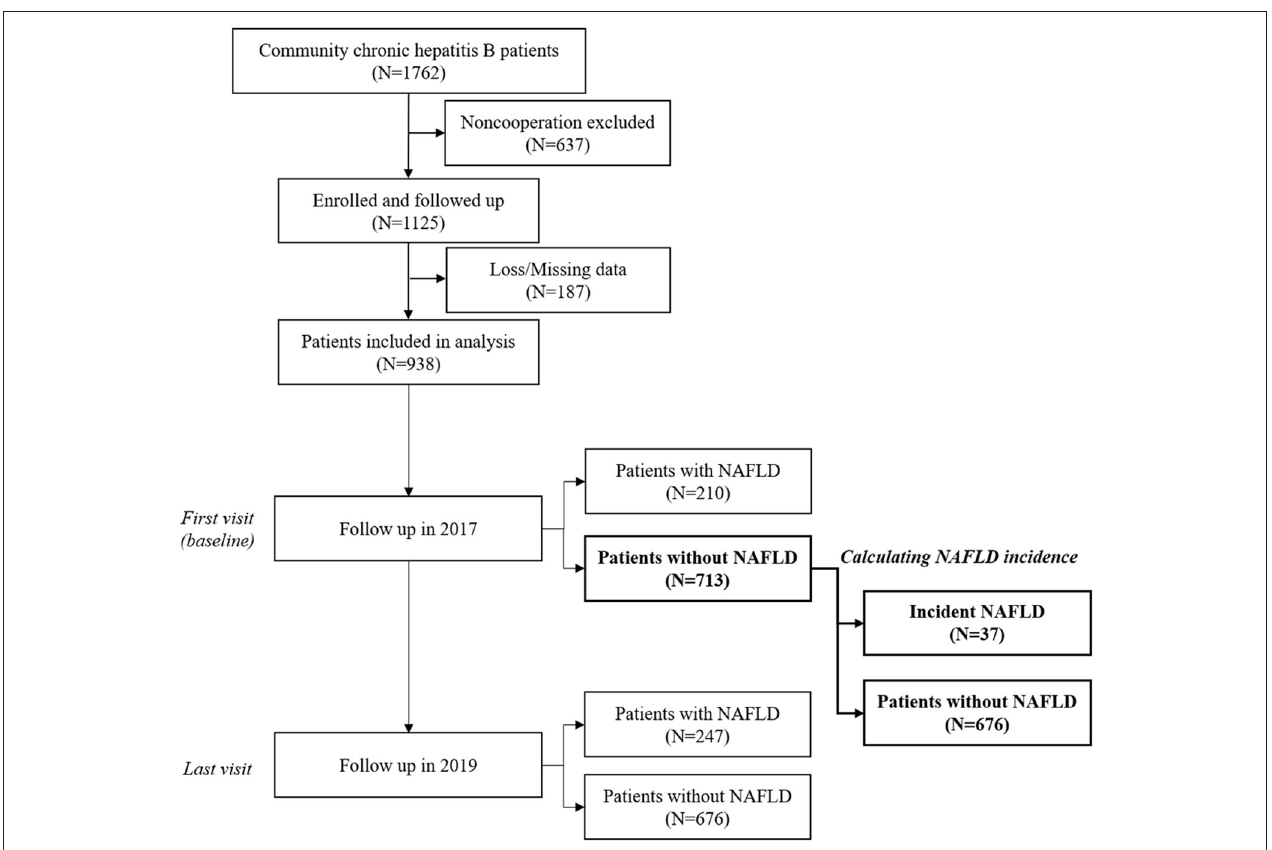
FIGURE 1 | Flow chart and timeline of patient selection and follow-up. NAFLD, non-alcohol fatty liver disease. multivariate Cox regression model demonstrated ALP ≥ 125